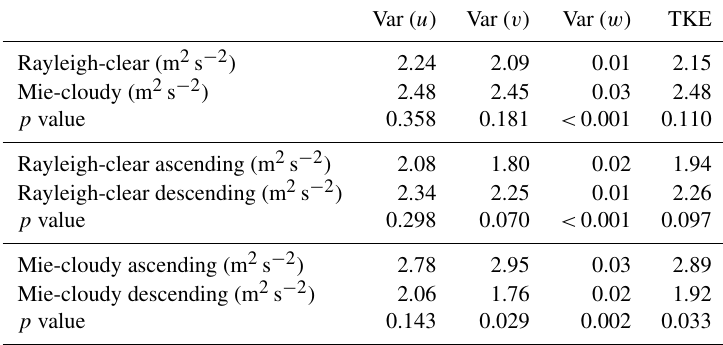
Table 6. Results of wind variability based on WPR